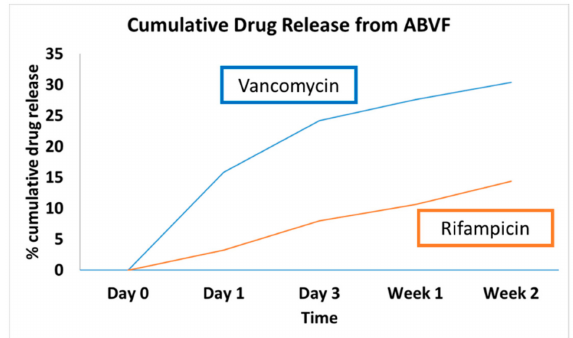
Figure 1. HPLC showed sustained release of vancomycin and rifampicin from ABVF. There was an initial burst release of vancomycin at day 1. Rifampicin showed release in a sustained manner.